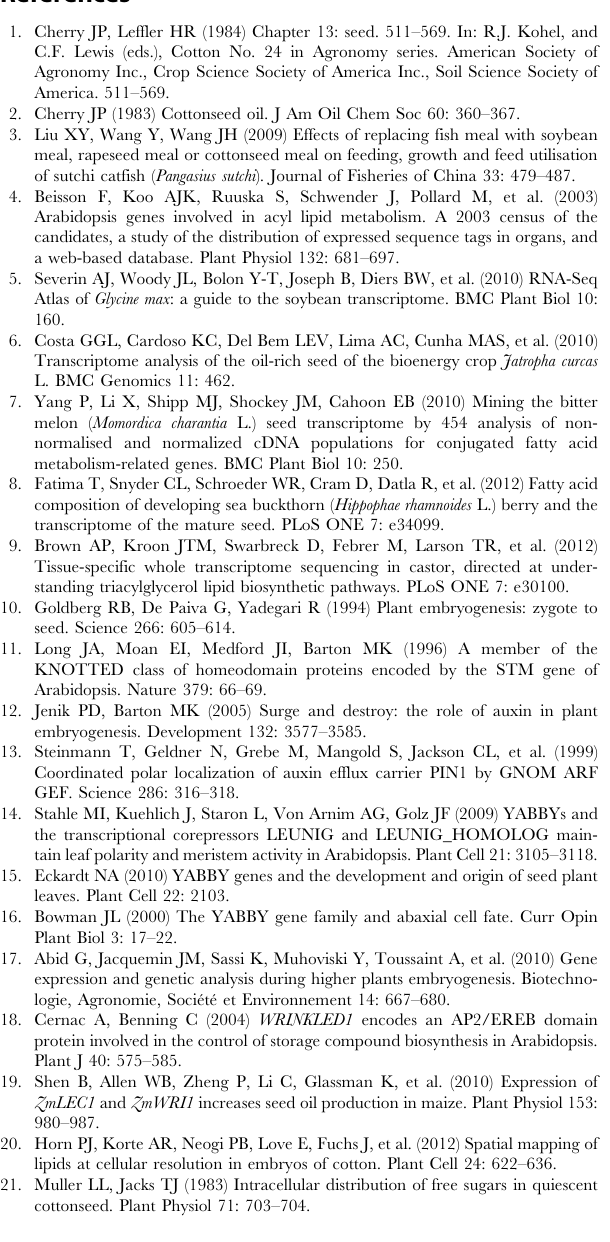
Table S6 Expression profile of seed storage proteins, LEA and LTP genes. (XLSX) Table S7 A list of genes involved in gossypol biosynthe- sis. (XLSX) Table S8 A list of primer sequences used for real time